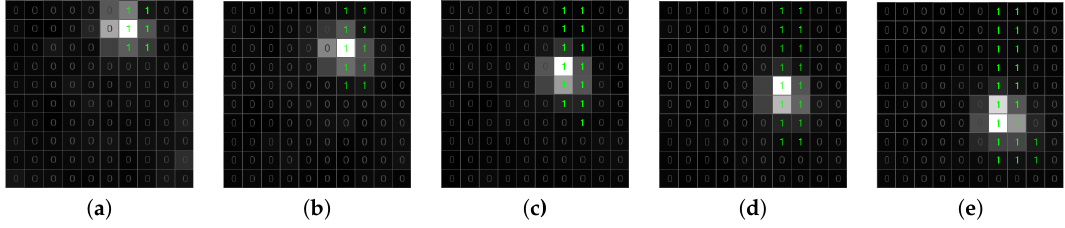
Figure 15. True positive example. ( a ) Time T. ( b ) Time T + 15 ms. ( c ) Time T + 30 ms. ( d ) Time T + 45 ms. ( e ) Time T + 60